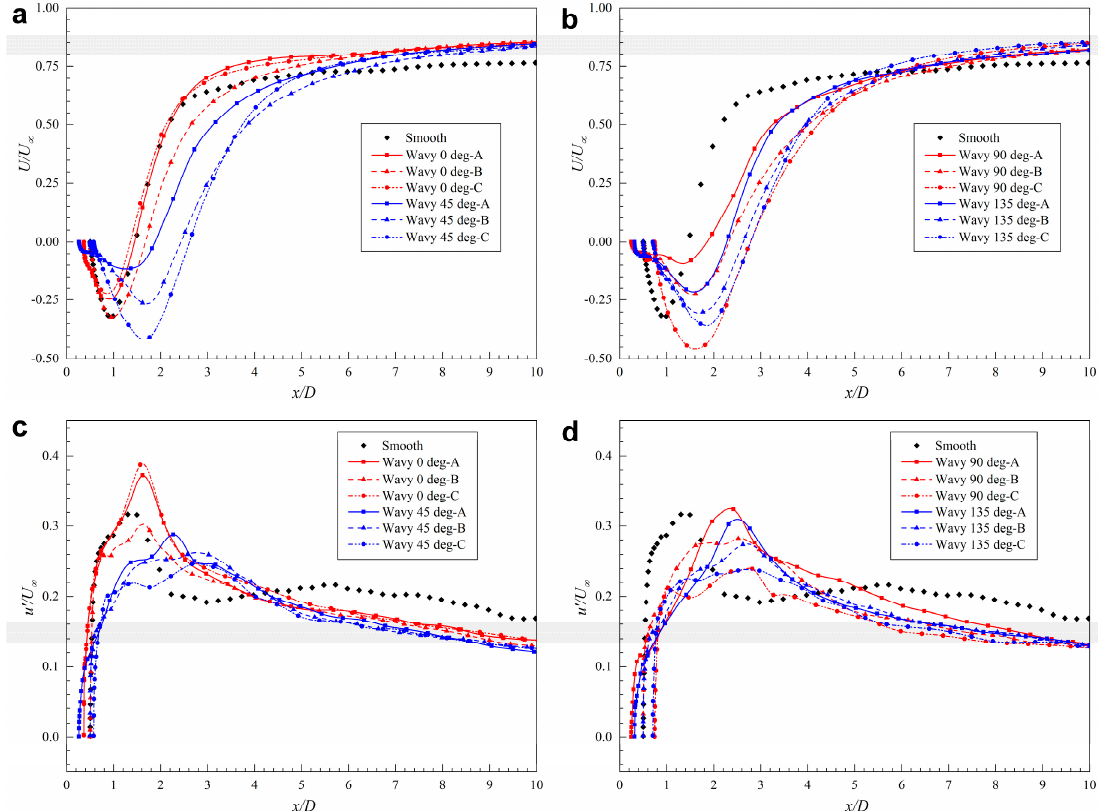
Figure 8. Comparison of ( a – b ) average streamwise velocity and ( c – d ) r.m.s. streamwise velocity distributions of the smooth cylinder and wavy cylinder A2 at four rotation angles.